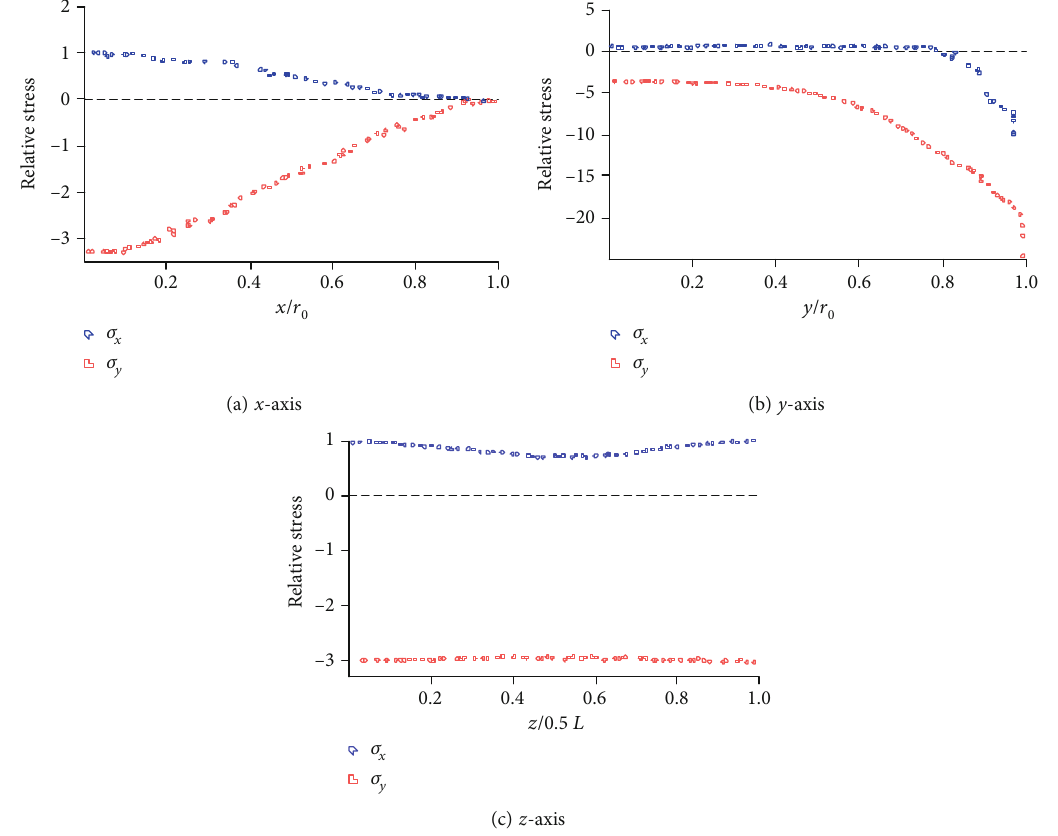
Figure 2: Stress distribution of the Brazilian disc in the three